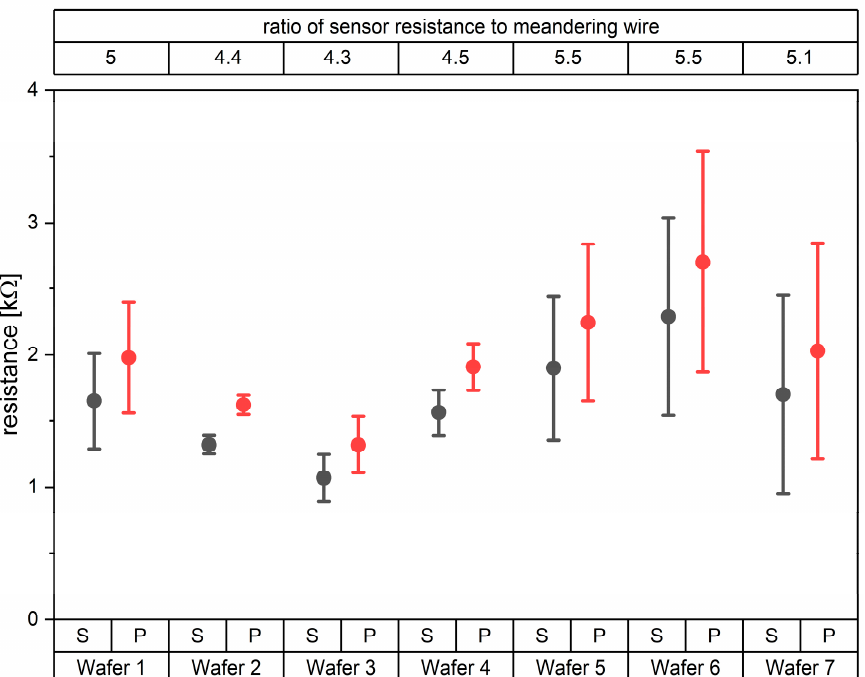
Figure 6. ( a ) Freely bendable sensor array was peeled off the glass wafer after laser cutting. ( b ) Detail view showing 32 contact pads in the area reserved for soldering the chip and 12 micro-vias in the area of one sensor node.